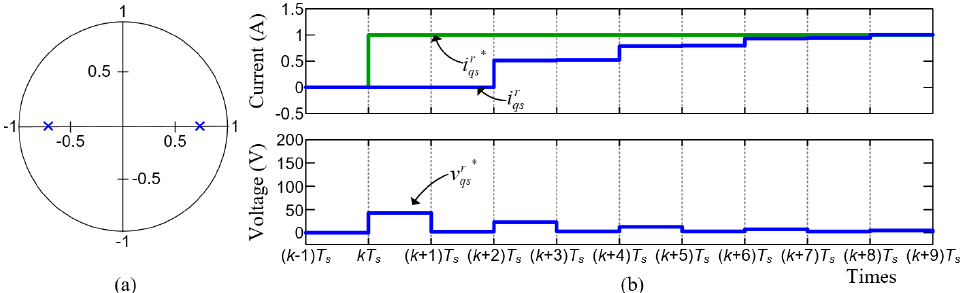
Figure 13. ( a ) The dominant poles and ( b ) simulated q -axis current and voltage command response with ˆ L qs = 0.5 L qs when the current command steps from 0 A to 1 A, the motor is at standstill.